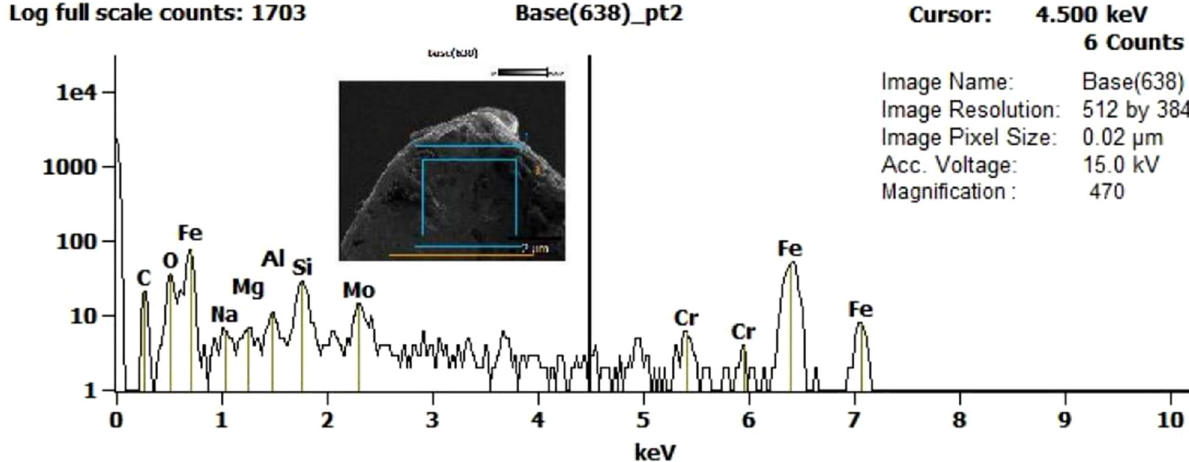
Fig. 5. Electronic dispersive spectrography of the deep cryo-treated tool.